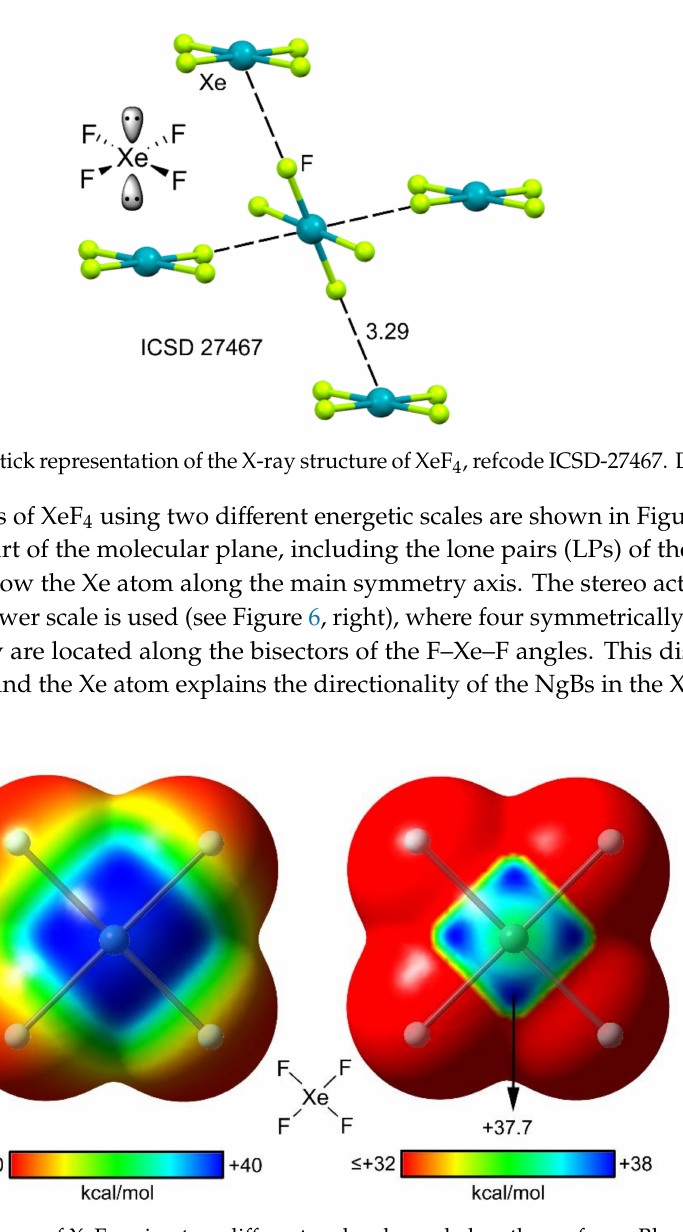
Figure 6. MEP surfaces of XeF 4 using two di ff erent scales shown below the surfaces. Blue color is used for the maximum and red color for the minimum MEP value. Isosurface 0.01